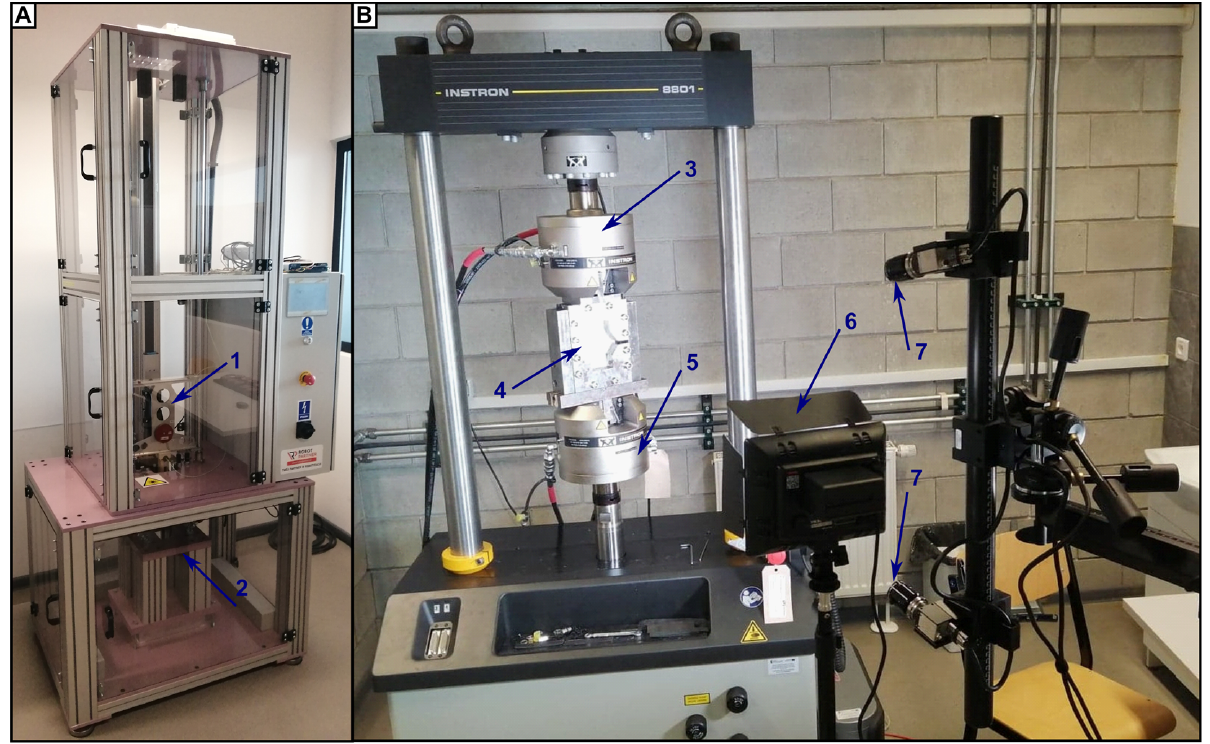
Figure 2. Presentation of used test stands for LVI tests ( A ) and CAI tests ( B ). The following features are marked: (1) impactor with dropping mass attached, (2) platform, (3) force registration cell, (4) CAI grip with mounted plate, (5) force generation cell, (6) light source, (7) DIC cameras.